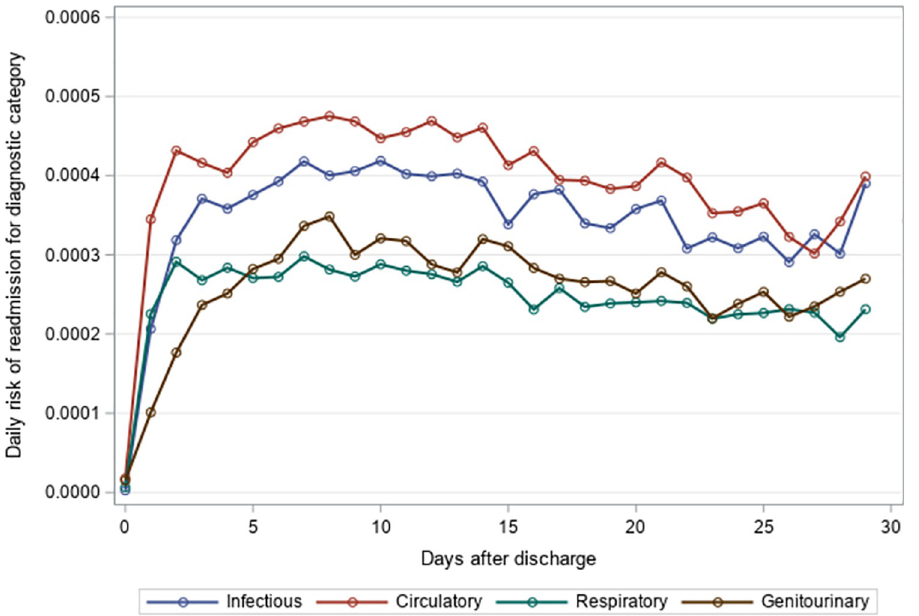
Fig 5. Daily risk of 30-day unplanned hospital readmission among older adults discharged to skilled nursing facilities following an index hospitalization for sepsis, 2013–2014. Presents the daily risk of unplanned hospital readmission for four common causes of readmission (infectious, respiratory, circulatory, genitourinary). Each year started on the Sunday of Morbidity and Mortality Weekly Report week 27 and ended on the Saturday of Morbidity and Mortality Weekly Report week 26 of the following year.